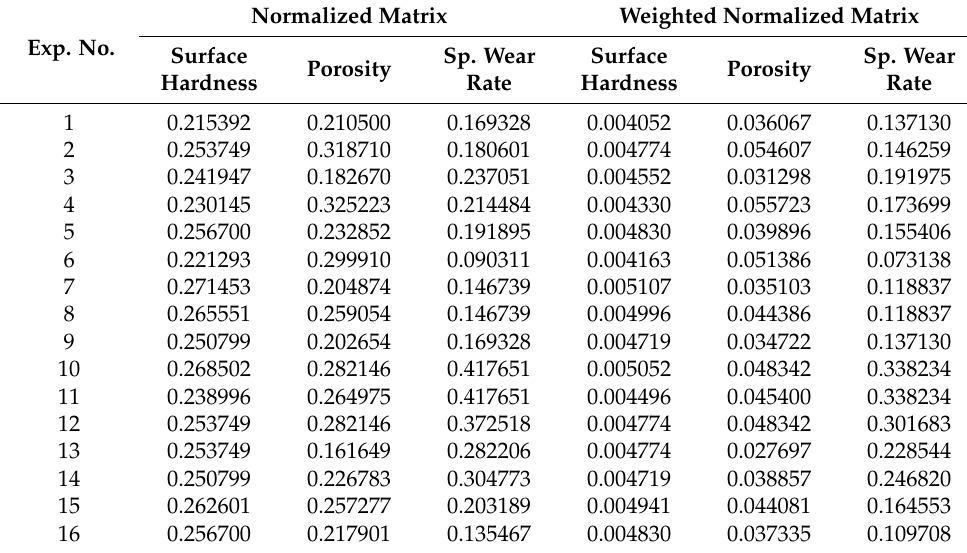
Table 2. Normalized and weighted normalized decision matrixes for case study